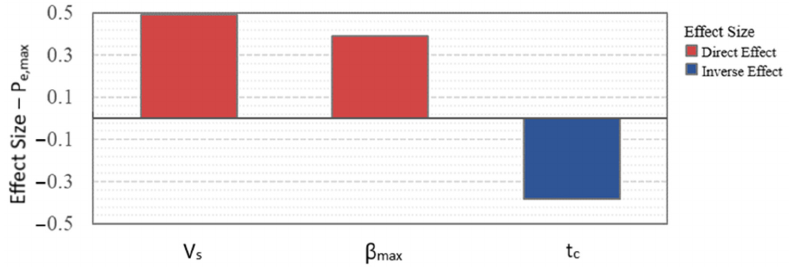
Figure 2. Relationship between the maximum power absorbed by the compressor P e , max and the input variables ( V s , β max , t c ) .